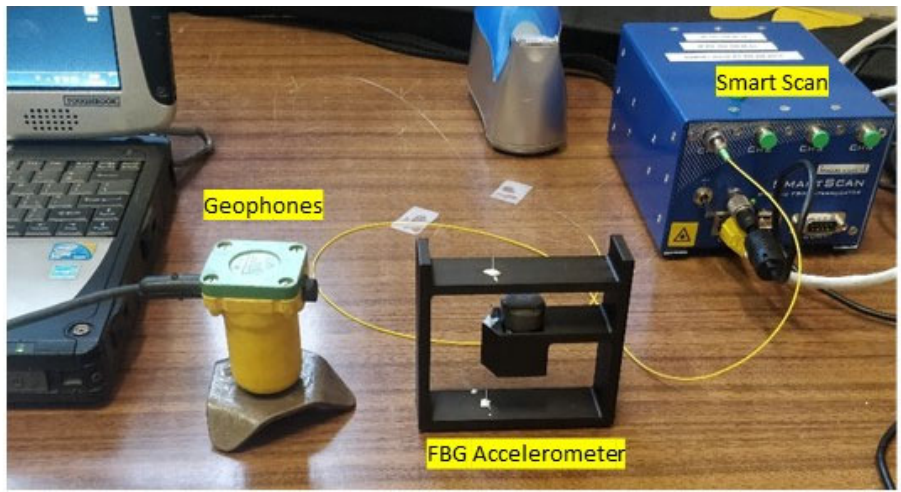
Figure 2. Comparison test between the FBG accelerometer and a standard vertical 4.5 Hz geophone in the laboratory with external hammer shots.